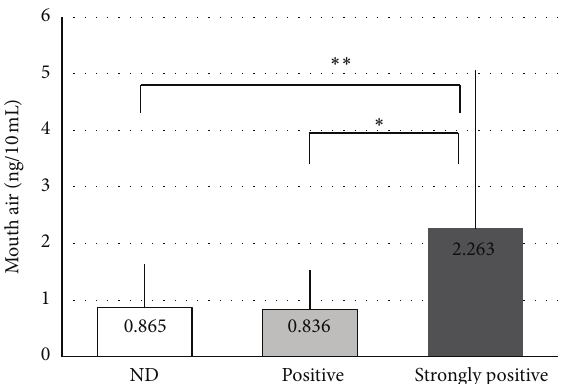
Figure 4: Correlations between the methyl mercaptan measure- . Vertical line: SD. Statistical comparison was performed using unpaired 𝑡 -tests.